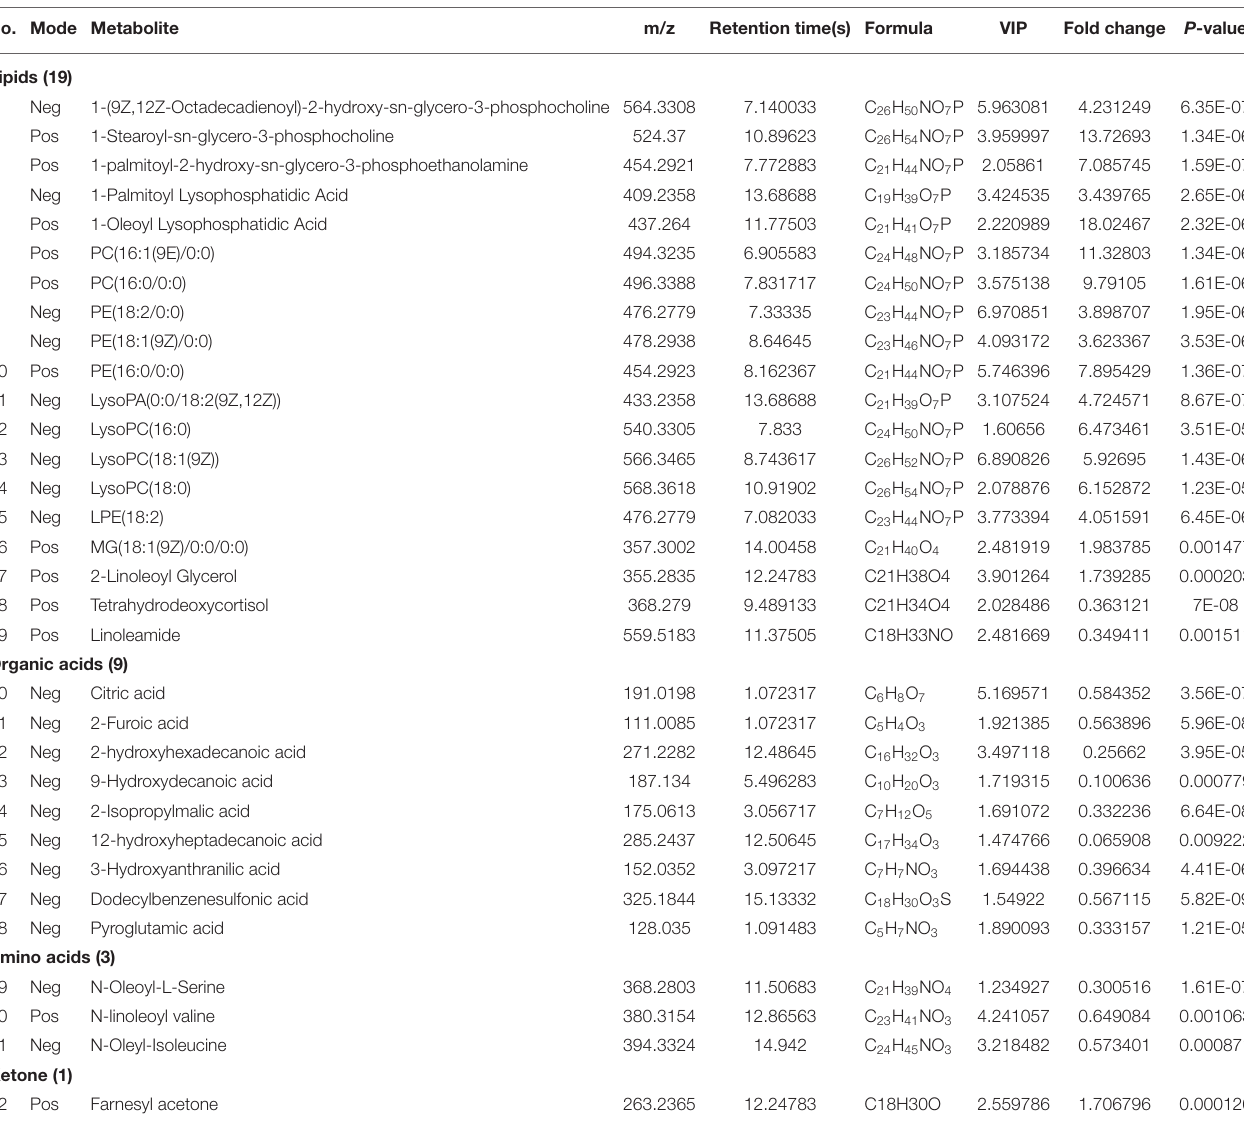
TABLE 2 | Differentiating metabolites between four regions with VIP > 1 and P <